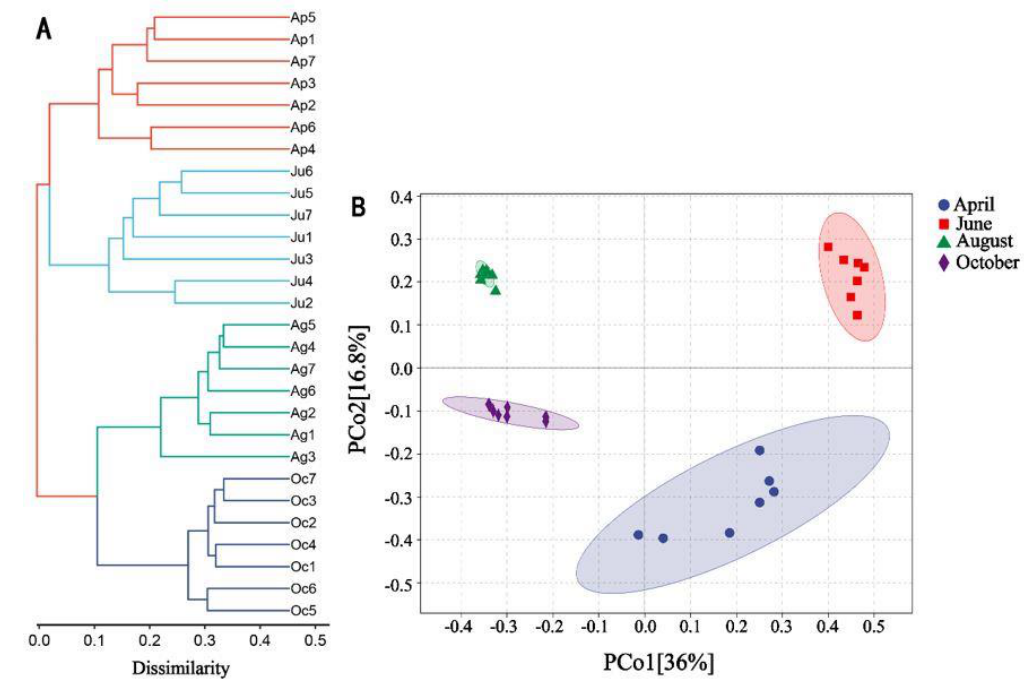
Figure 2. Hierarchical clustering analysis ( A ) and principal coordinates analysis ( B ) of microbial communities.